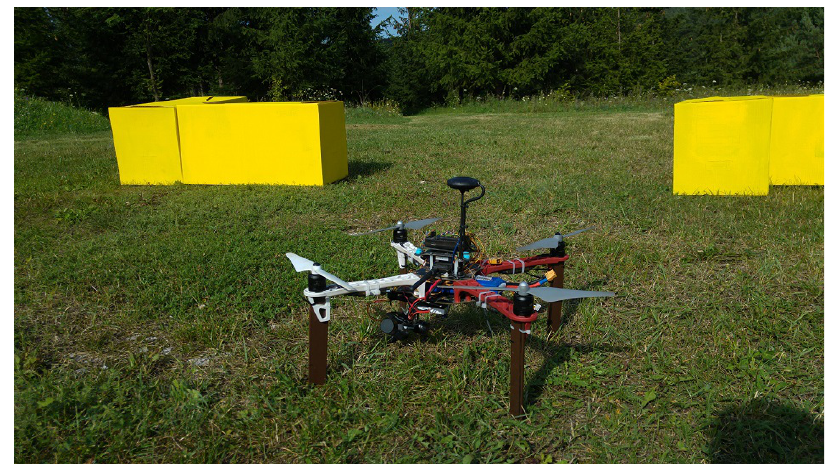
Figure 18. Robot used for